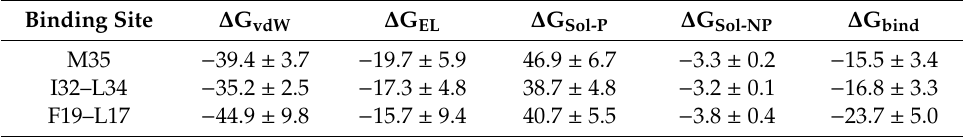
Table 1. Doxycycline–A β fibrils (2MXU) binding energy from MM-PBSA. ∆ G EL represents the electrostatic interaction energy, ∆ G vdW the van der Waals interaction, ∆ G Sol-P the polar contribution to the solvation energy, ∆ G Sol-NP the non-polar contribution to the solvation energy, and ∆ G bind the total binding energy. All values are in kcal /